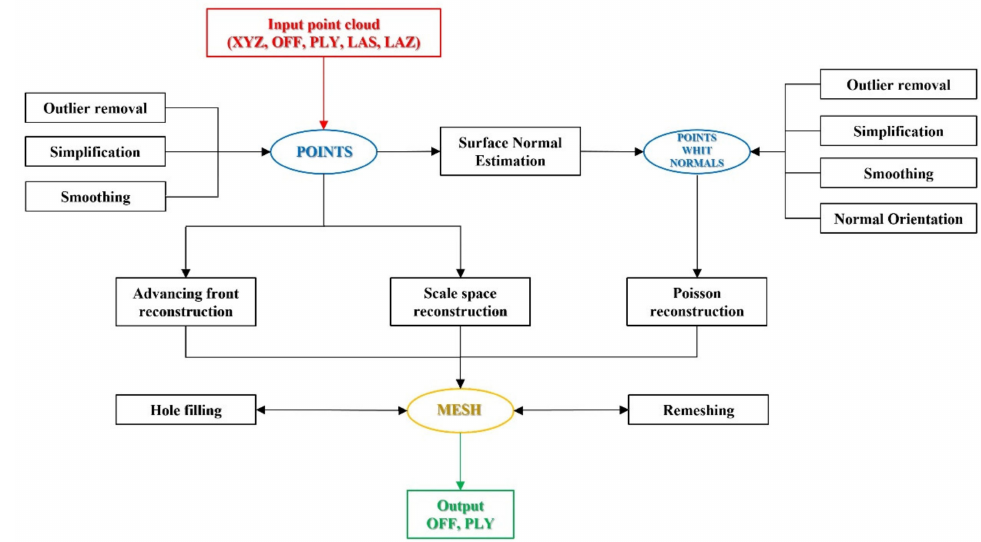
Figure 15. Surface calculation